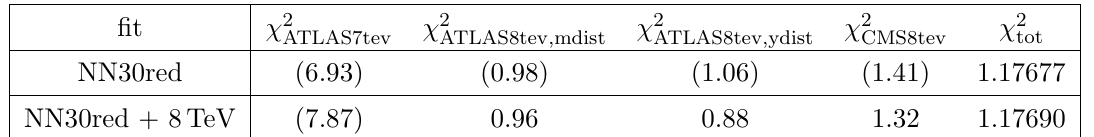
Table 10 . Fully-correlated (cid:31) 2 per degree of freedom when the p Z The numbers in brackets correspond to the (cid:31) 2 for experiments which are not (cid:12)tted. The total (cid:31) 2 is computed over all data in the baseline (cid:12)t and the included p Z slightly-modi(cid:12)ed NNPDF3.0 global baseline as NN30red in the table below.